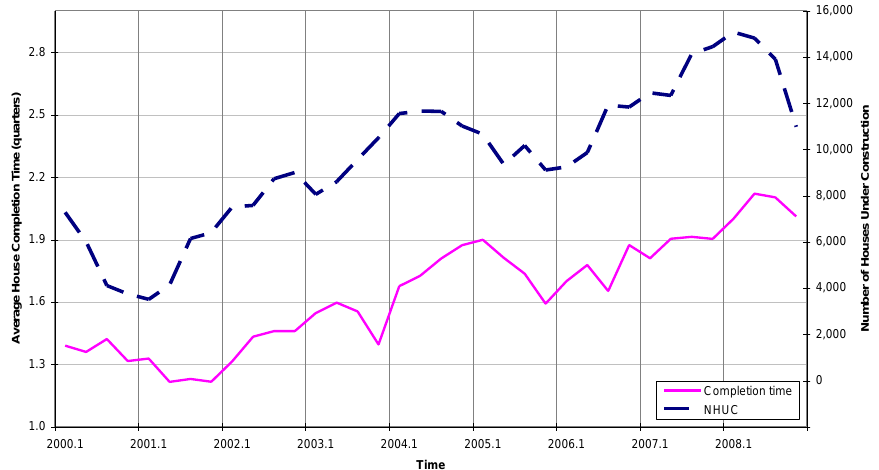
Figure 11: the trend of number of houses under construction and the average house completion time in